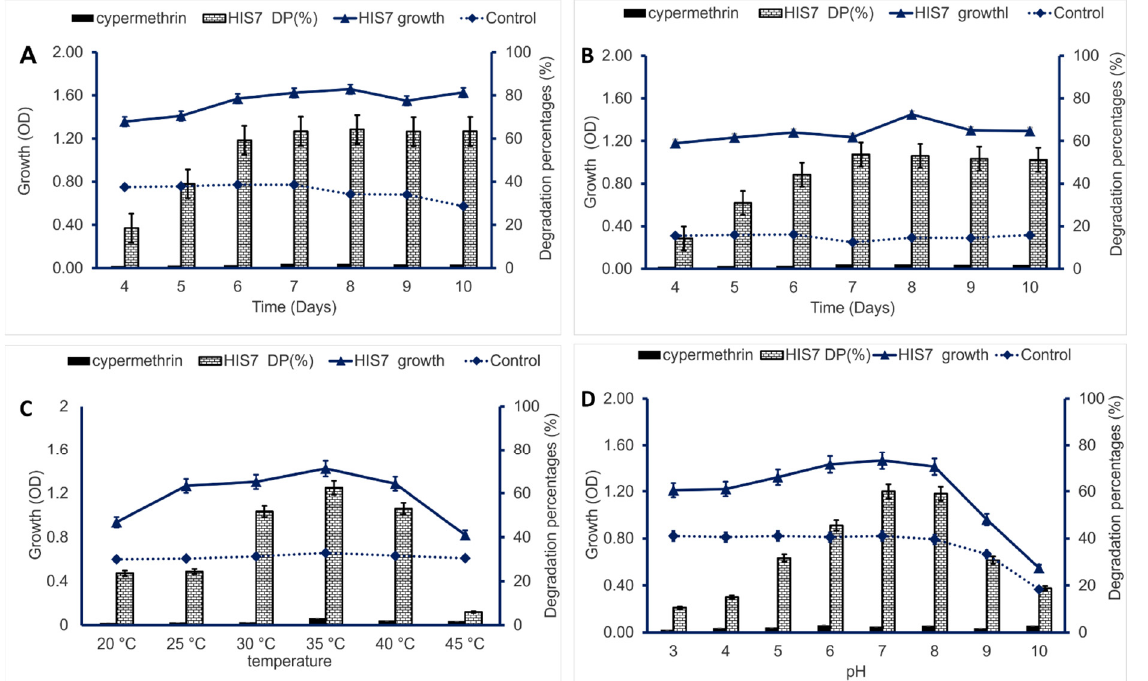
Figure 3. The optimization process of cypermethrin bacterial degradation. Panels ( A , B ) denote the optimum incubation periods at static and shaking conditions, respectively; panel ( C ), optimum temperature; panel ( D ), optimum pH values. Cypermethrin meaning the abiotic degradation percentages of insecticide in MS liquid media in absence of bacterial inoculation; HIS7 DP (%) denotes the degradation percentages of cypermethrin in MS liquid media in presence of Lysinibacillus cresolivuorans strain HIS7; HIS7 growth denotes the bacteria growth (O.D.) in MS liquid media containing cypermethrin; Control denotes the bacterial growth (O.D.) in MS liquid media in absence of cypermethrin. Data represented by Mean ± SE (n = 3). The standard deviation is less than the size of symbols if no error bars are seen.